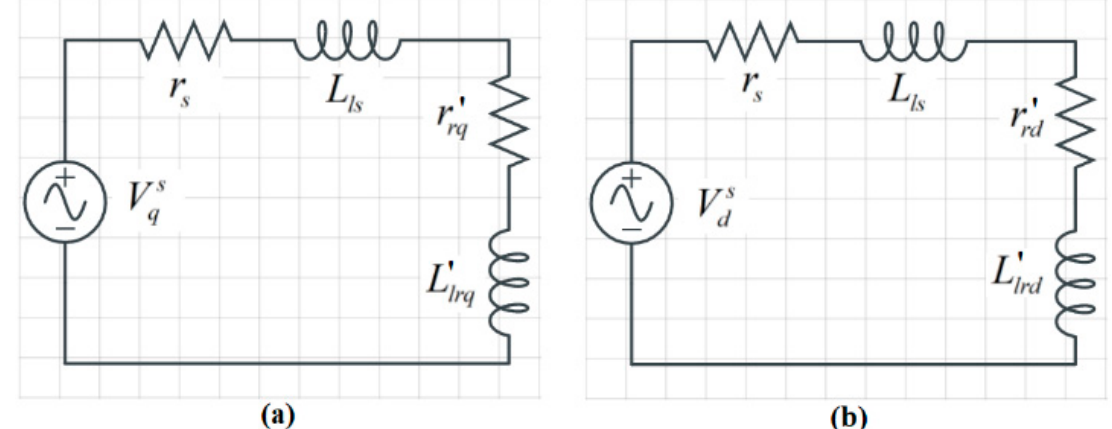
Figure 9. LSPMSM circuit under locked rotor conditions ( a ) q-circuit ( b ) d-circuit.